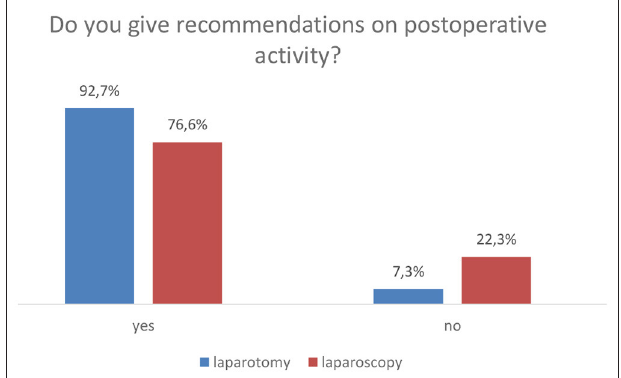
FIGURE 1 | Comparison of whether recommendations of postoperative activities are given to patients in case of laparotomy and laparoscopy. n/a, not answered. N = 385, p = 0.000 (chi-squared